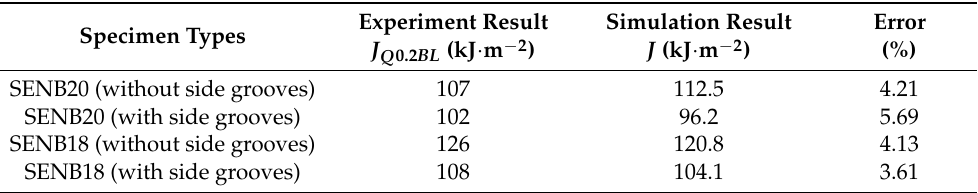
Figure 7. J -integral fitting resistance curves and passivation lines at 0.2 mm of SENB20 and SENB18 specimens: ( a ) SENB20; ( b ) SENB18. Table 7. Comparation of fracture toughness values obtained from experiment ( J Q 0.2 BL ) and simulation ( J )